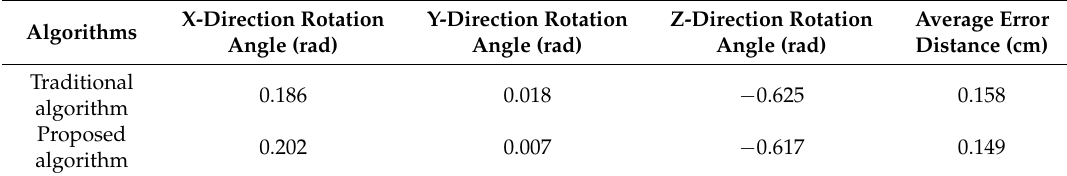
Table 4. Experimental results of different algorithms.